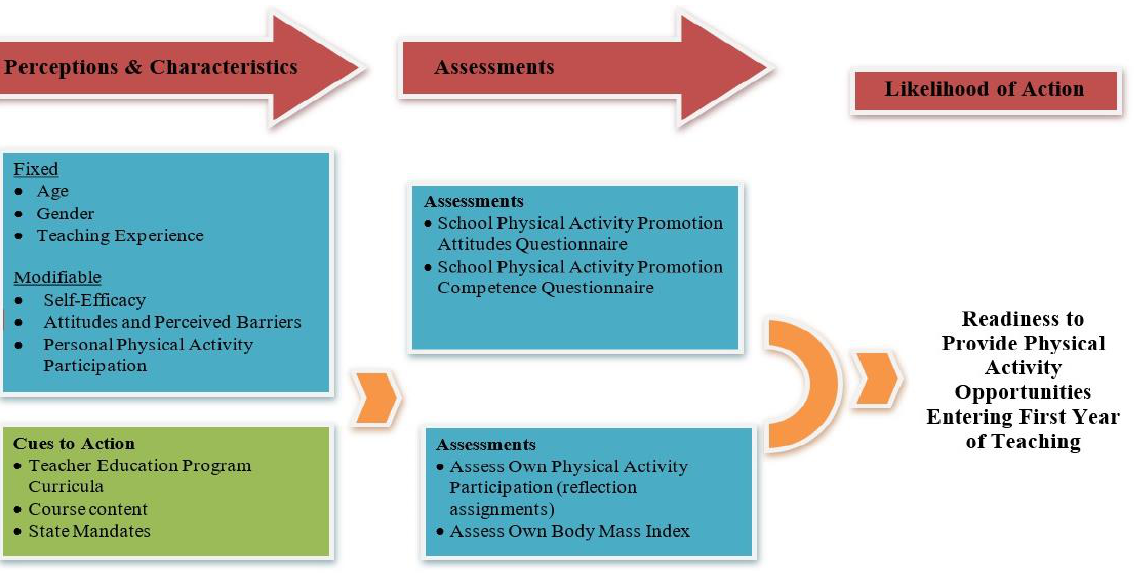
Figure 1. Integrating the Health Belief Model framework into the ACTIVE YOU preservice teacher intervention.